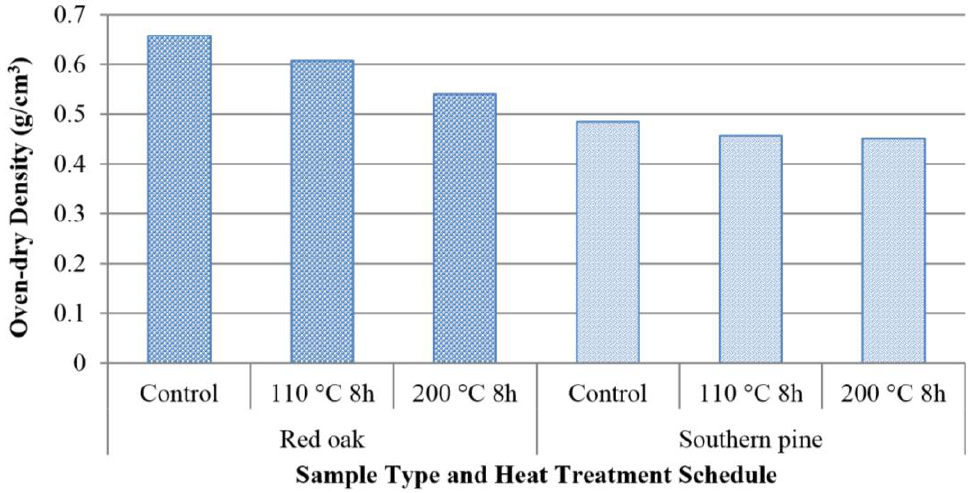
Figure 2. Oven-dry density values of the